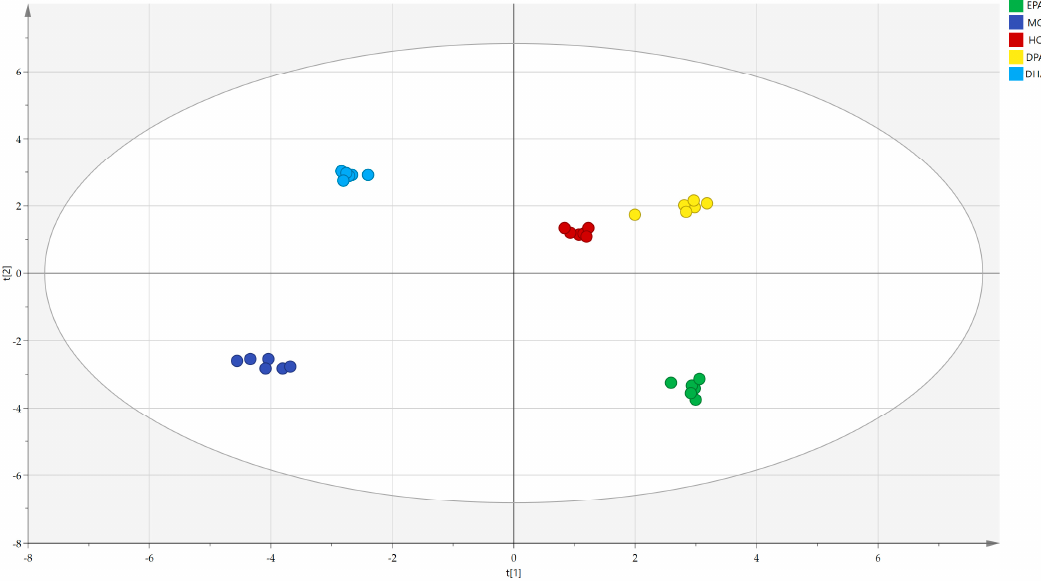
Figure 9. The correlation analysis of the metabolites in different groups evaluated by PCA. Note: t (1)and t (2) represent the corresponding explanation rate of principal component 1 (46.1%) and principal component 2 (39.4%); EPA, DPA, DHA, MC, HC represent EPA group, DPA group, DHA group, model control group, health control group,